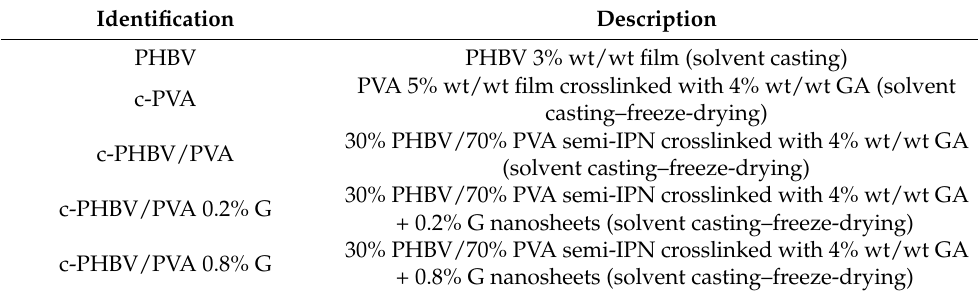
Table 1. Notation of the samples.